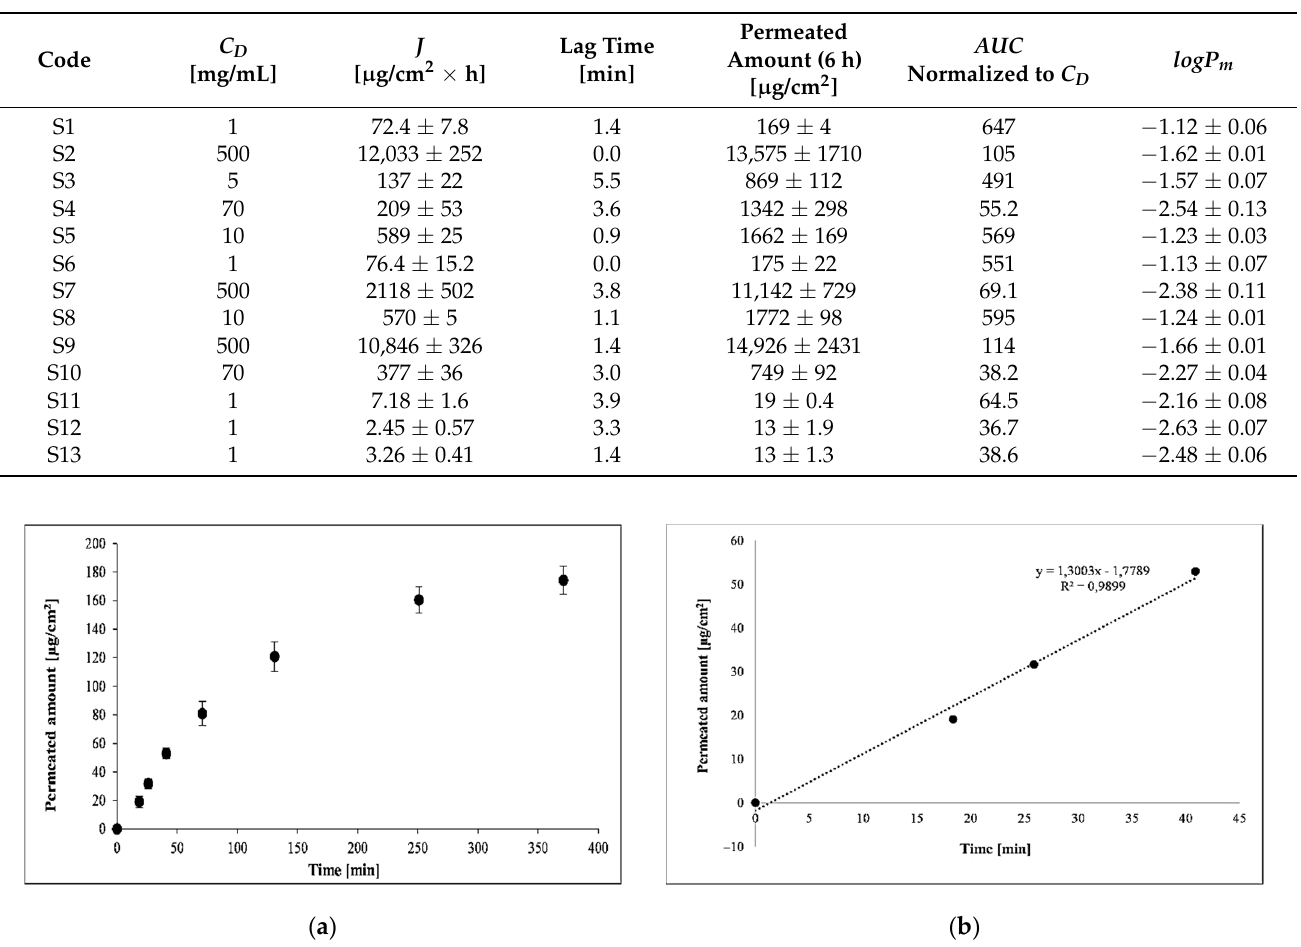
Figure 2. ( a ) The permeability profile of PER dissolved in water using Skin-PAMPA; ( b ) The linear regression curve used for the calculation of flux. Table 3. Characteristic parameters of permeability of PER across Skin-PAMPA membrane for comparison when applied in different solvents.